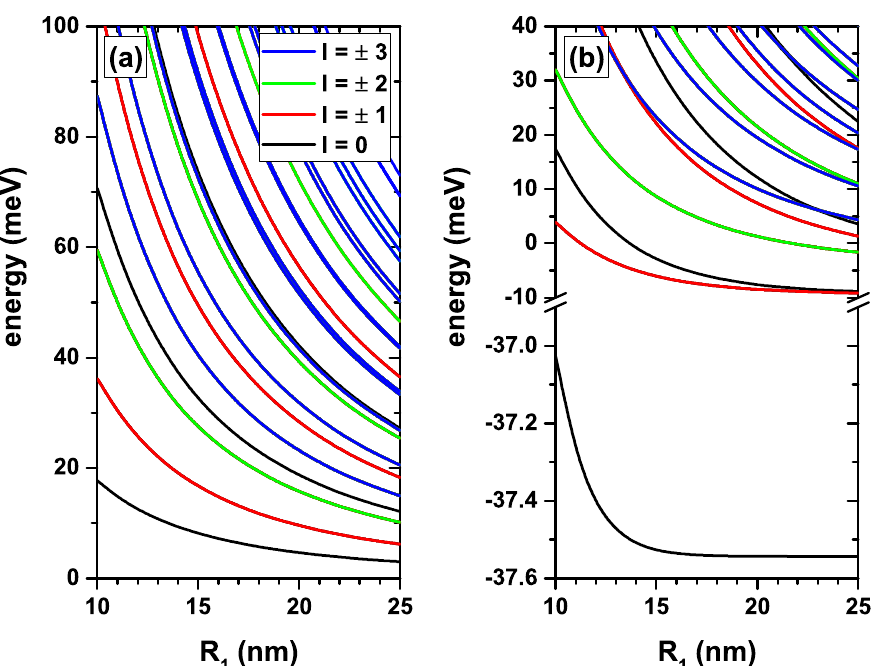
Figure 2. (color online) The lowest confined electron states in a CdS/ZnS spherical QD as functions of the R 1 -inner radius. Results are without ( a ) and with ( b ) on-center donor impurity, with R 2 = 30nm, for several values of the l -quantum number, and without EF and MF